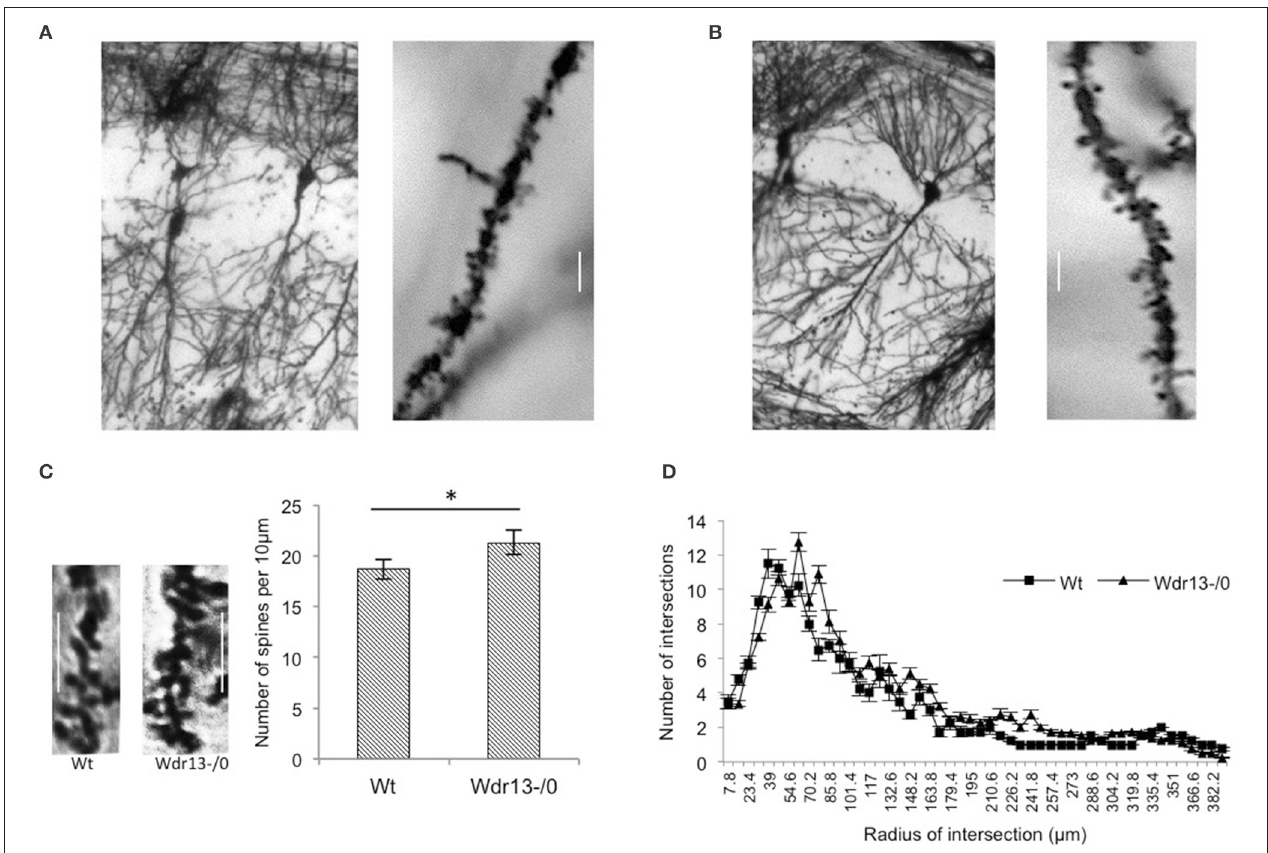
FIGURE 6 | Analysis of spine density and dendritic branching of CA1 neurons of the hippocampus from wild-type and Wdr13 − / 0 mice. (A,B) Representative pictures of wild-type (left) and Wdr13 − / 0 (right) CA1 neurons and spines. (C) The spine density of apical CA1 neurons was significantly ( T -test; p < 0.05) higher in Wdr13 − / 0 mice as compared to the wild-type. Scale: 5 µ m. (D) There was no significant difference (ANOVA; p > 0.05) in dendritic branching of CA1 neurons of Wdr13 − / 0 and wild-type mice. Data represented as ± SEM. Wt, wild-type; Wdr13 − / 0 , Wdr13 knockout mice. * p <